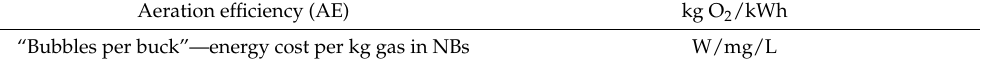
Table 1. Several obvious competitive performance metrics for assessing NB generation. Competitive Performance Indicator Value Bubble lifetime: exponential-decay half-life Minutes to months, depending on gas/solvent type Energy cost of Aqua-B NB generators kW/kg O 2 transferred/h Aeration efficiency (AE) kg O 2 /kWh “Bubbles per buck”—energy cost per kg gas in NBs